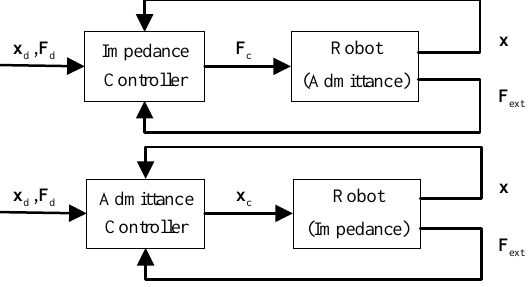
Figure 1. The control loops for impedance control (the upper one) and admittance control (the lower one). x d , F d are the desired trajectory and desired contact force; x c , F c are the inputs of the robot controllers; x , F ext are the actual motion trajectory of the robot and contact force, respectively. The dimensions and composition of the above vectors are related to specific